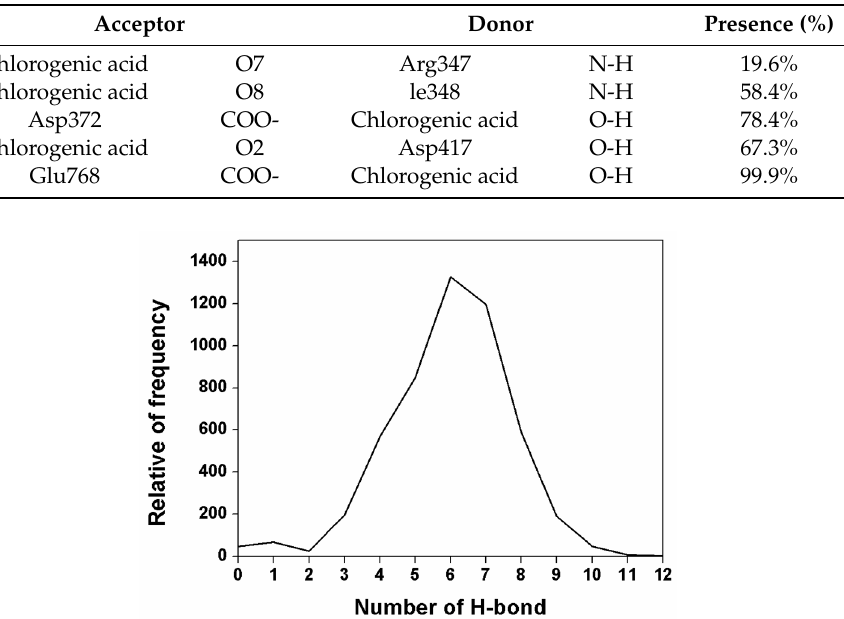
Table 1. Hydrogen bond occupancies for the NanA–chlorogenic acid complex.